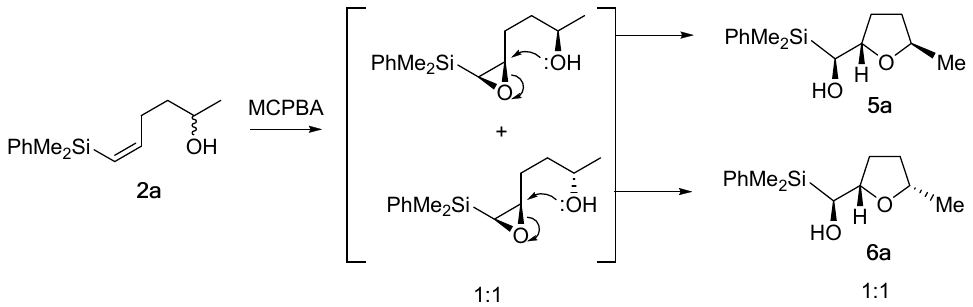
Scheme 4. Stereoselective outcome of the domino epoxidation-cyclization process.